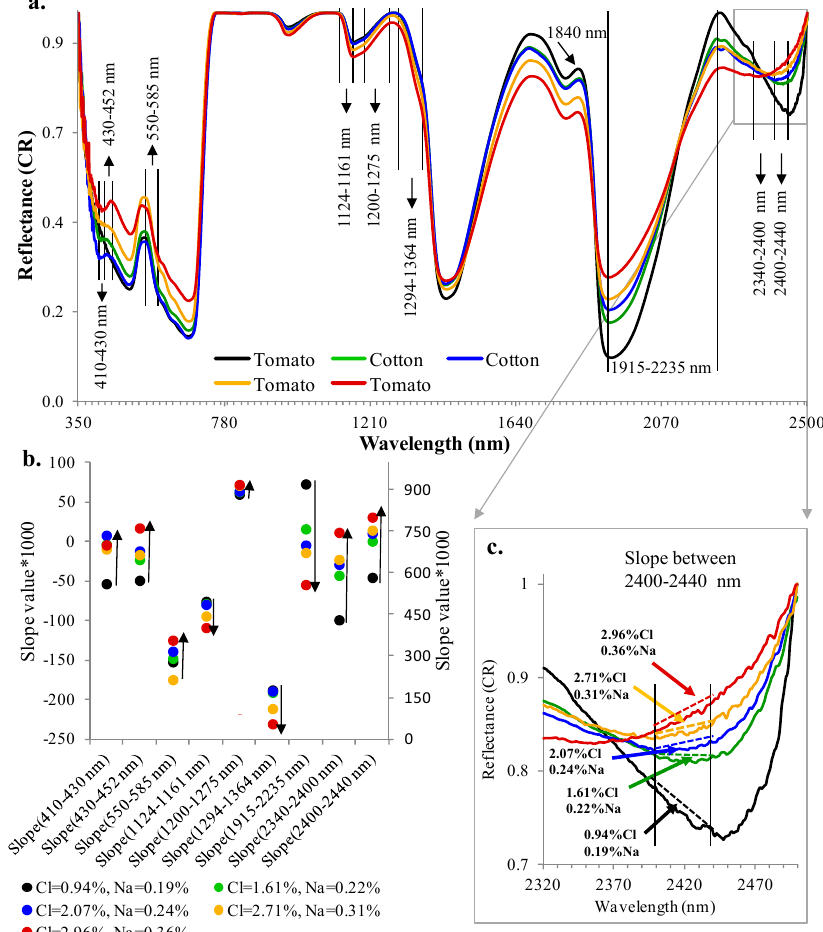
Figure 3. ( a ) Continuum removal (CR) reflectance spectra of vegetation samples with different percentages of Cl/Na. Note the variability in the slopes across the different spectral ranges: 410–430 nm, 430–452 nm, 550–585 nm, 1124–1161 nm, 1200–1275 nm, 1294–1364 nm, 2340–2400 nm, and 2400–2440 nm. Note that both cotton and tomato leaves exhibit spectral variability across similar spectral ranges as a function of changes in salinity levels. Therefore, both populations can be combined in the analyses; ( b ) visualization of the slopes’ tendency to increase or decrease as a function of different Cl/Na contents (the right Y axis is the scale for the slope between 1915 and 2235 nm). Up-pointing arrow indicates a slope increase with Cl/Na content increase; down-pointing arrow indicates a slope decrease with Cl/Na content increase; and ( c ) zooming in on the 2400–2440 nm spectral range to demonstrate the changes in slope with changes in Cl/Na concentration.